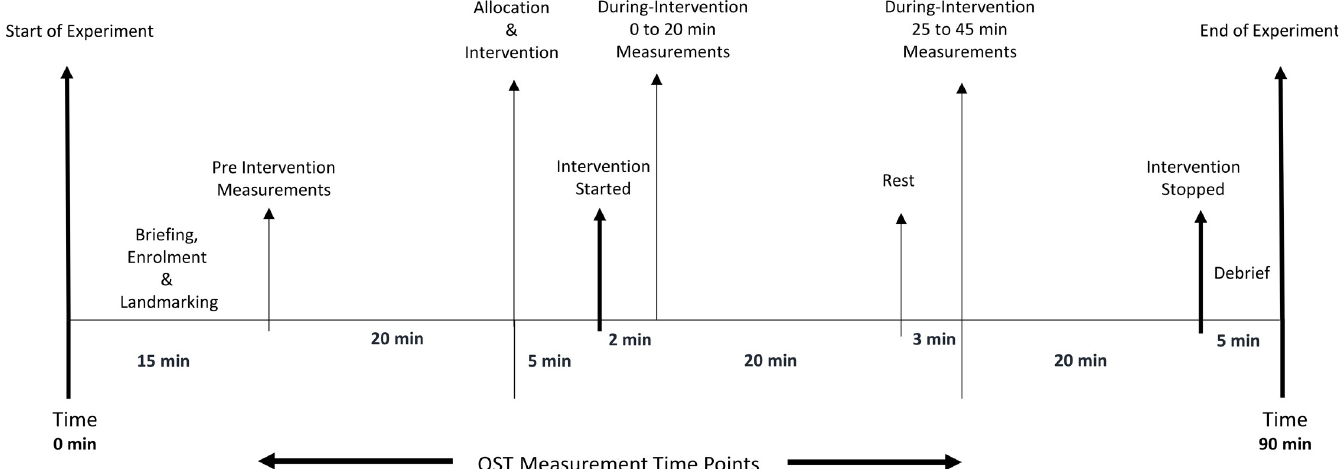
Fig 3. Sequence of events of the experimental